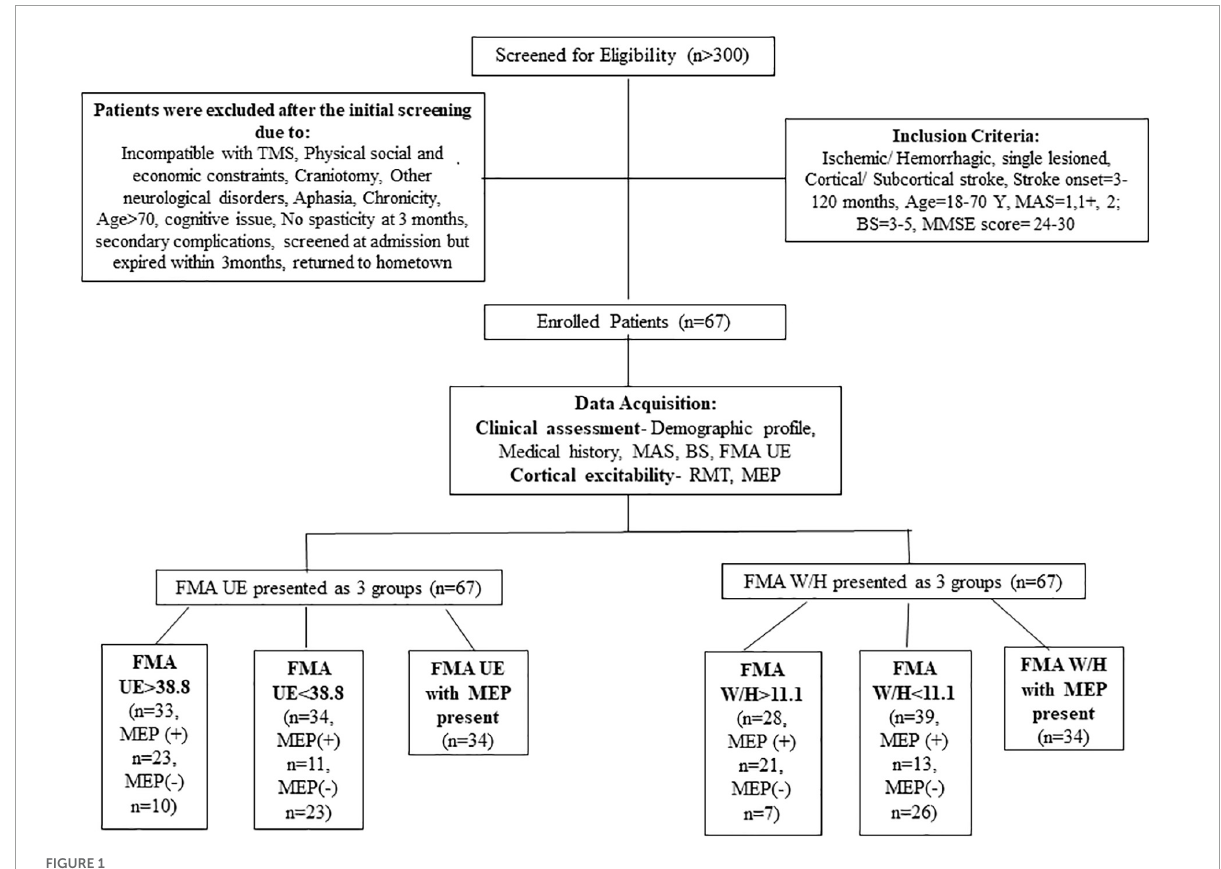
FIGURE1 Patient enrolment and group